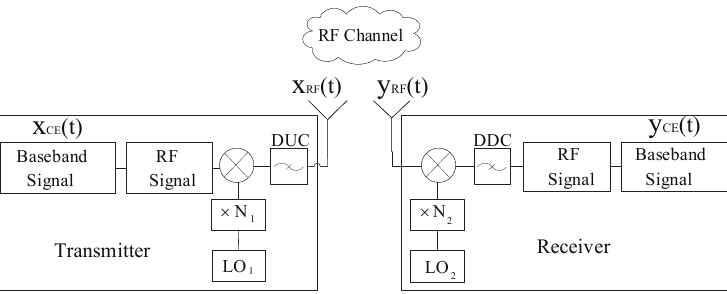
Figure 2. the schematic diagram of wireless communication